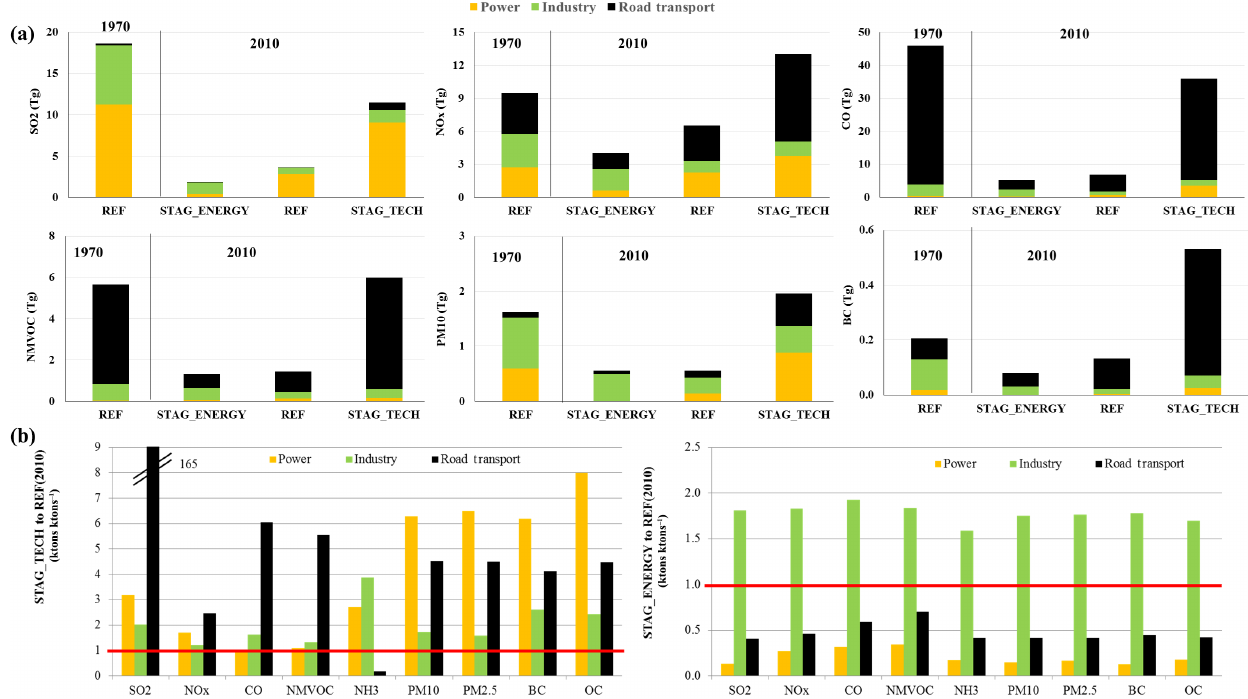
Figure 4. (a) Overview of 1970 (only for REF) and 2010 emissions for REF, STAG_TECH and STAG_ENERGY at the European scale for the power generation, industry and road transport sectors. (b) The ratios in 2010 of STAG_ENERGY to REF(2010) and STAG_TECH to REF(2010) are presented. The red-line indicates no change relative to the reference emissions in